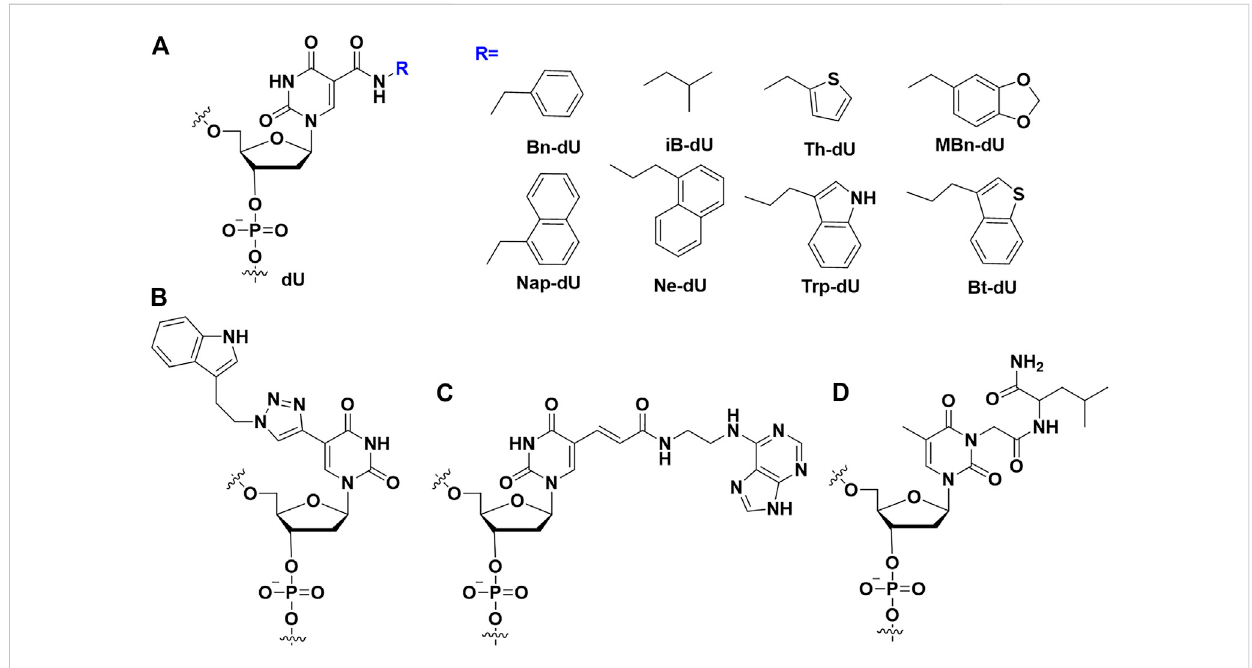
FIGURE 2 Thenucleobasesmodi fi cationsontheaptamerstoenhancebindingaf fi nity. (A) SOMAmersmodi fi cation; (B) Modi fi eduridinebyclickchemistry; (C) Base-appended bases modi fi cation; (D) Amino acid (leu) modi fi